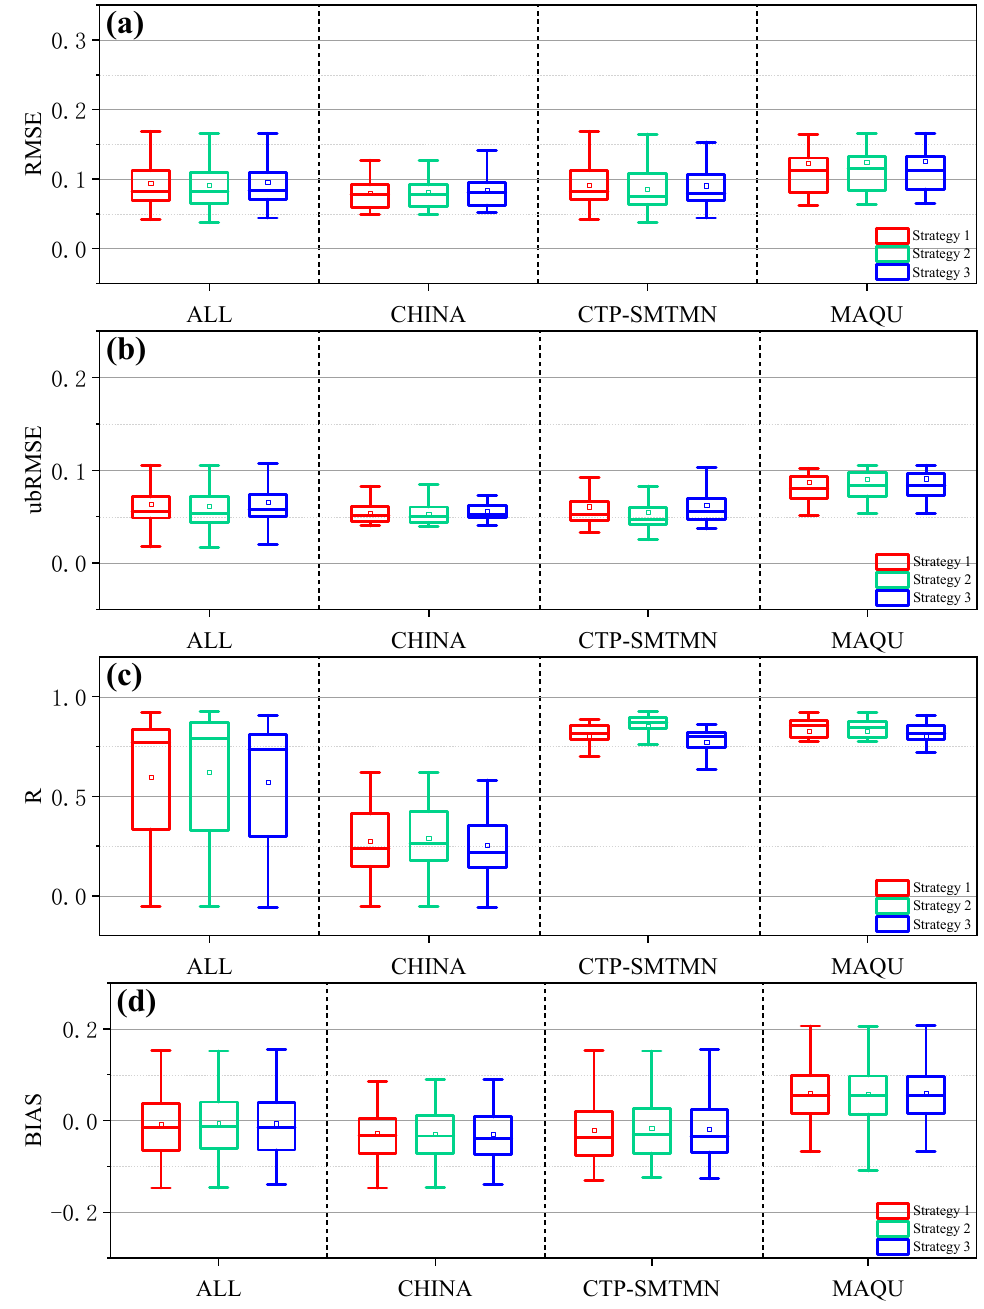
Figure 10. Comparisons of estimated SM by different strategies with the in situ SM using ( a ) RMSE, ( b ) ubRMSE, ( c ) R, and ( d ) BIAS.